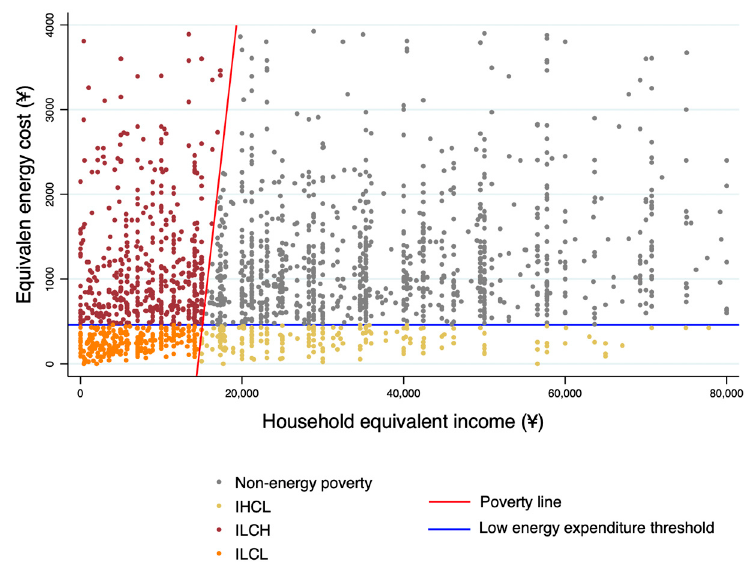
Figure 2. Distribution of households in different poverty categories.